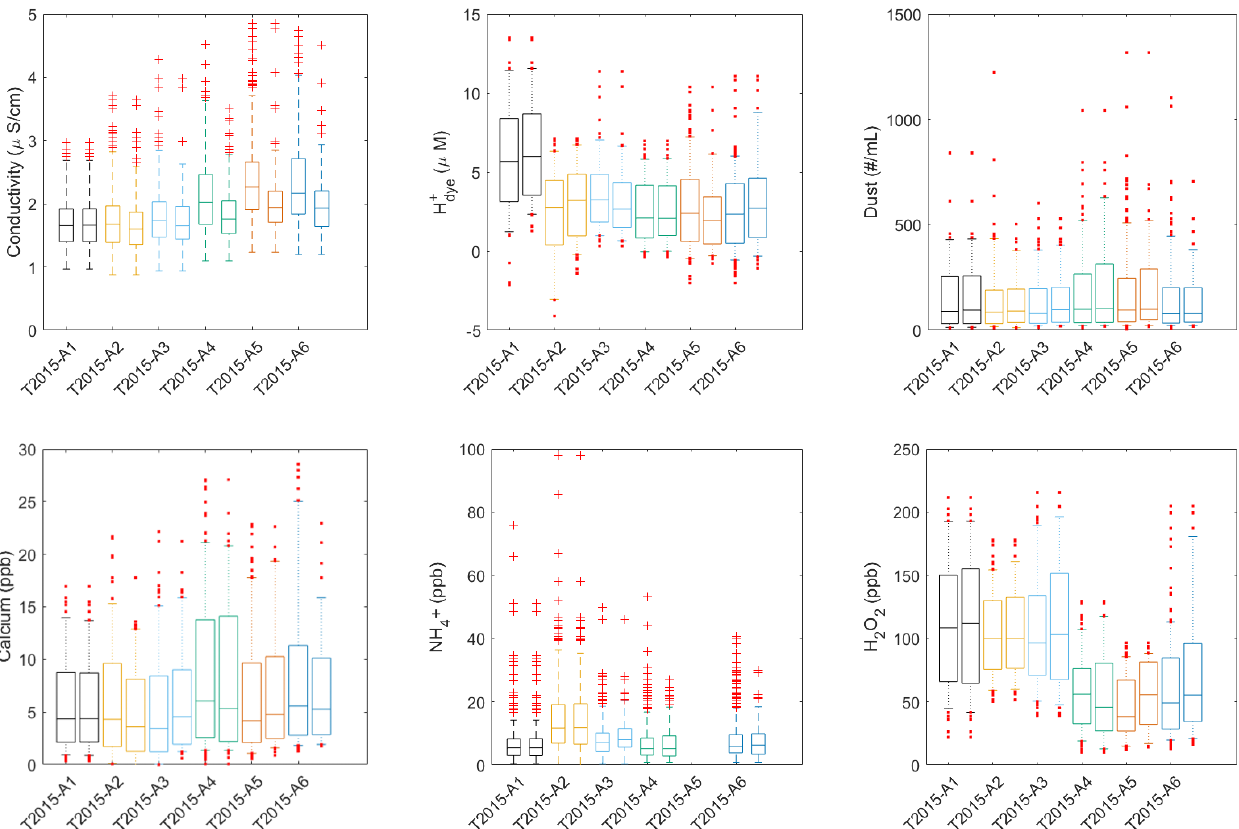
Figure 3. Statistical representation of the monthly mean datasets. The central mark indicates the median, and the bottom and top edges of the box indicate the 25th and 75th percentiles, respectively. The whiskers extend to the 2.5th and 97.5th percentiles. Red dots shows data exceeding the 2.5th and 97.5th percentiles. From left to right, T2015-A1 (black), T2015-A2 (yellow), T2015-A3 (light blue), T2015-A4 (green), T2015-A5 (orange) and T2015-A6 (dark blue) are shown. Two sets are shown for each core to make comparable estimates between sites: on the left for the full temporal record available and on the right for the period 2000CE and